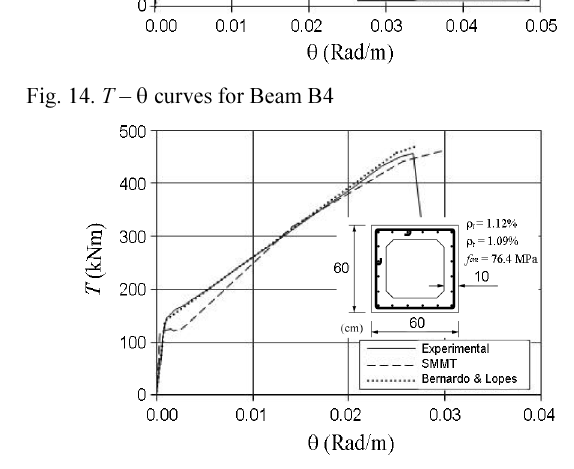
Fig. 11. T – θ curves for Beam A5